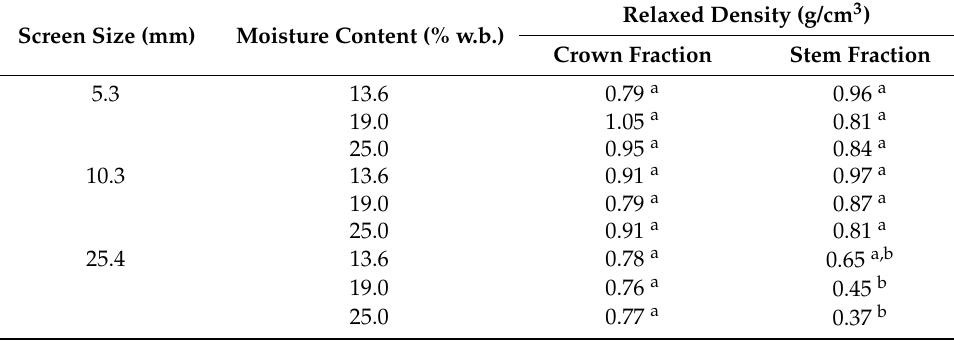
Table 4. Mean values of relaxed density of briquettes from poplar tree